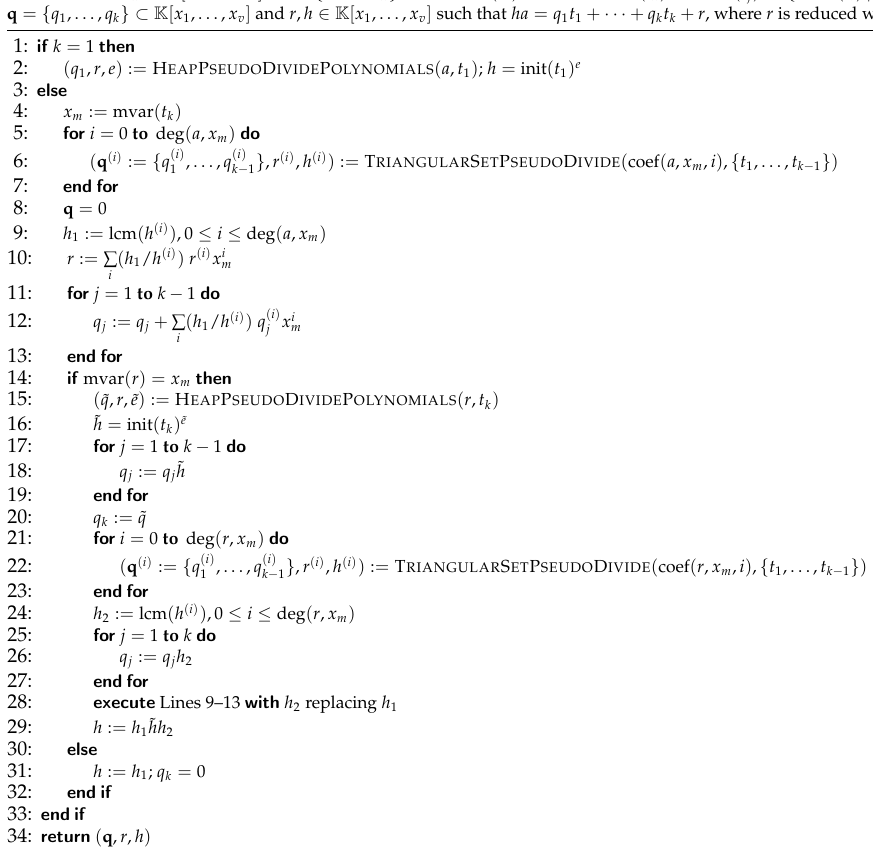
Algorithm 8 T RIANGULAR S ET P SEUDO D IVIDE ( a , T ) Given a , t 1 ,..., t k ∈ K [ x 1 ,..., x v ] , T = { t 1 ,..., t k } , with mvar ( t 1 ) < ··· < mvar ( t k ) and init ( t j ) / ∈ { mvar ( t i ) | t i ∈ T } for 1 ≤ j ≤ k , returns q = { q 1 ,..., q k } ⊂ K [ x 1 ,..., x v ] and r , h ∈ K [ x 1 ,..., x v ] such that ha = q 1 t 1 + ··· + q k t k + r , where r is reduced with respect to T